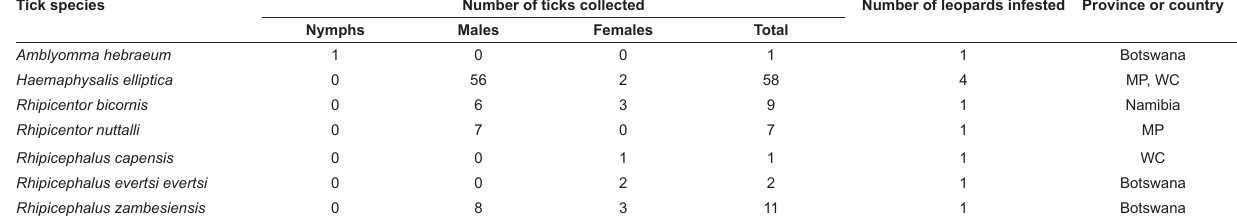
TABLE 6 Ticks collected from 8 leopards in South Africa, Botswana and